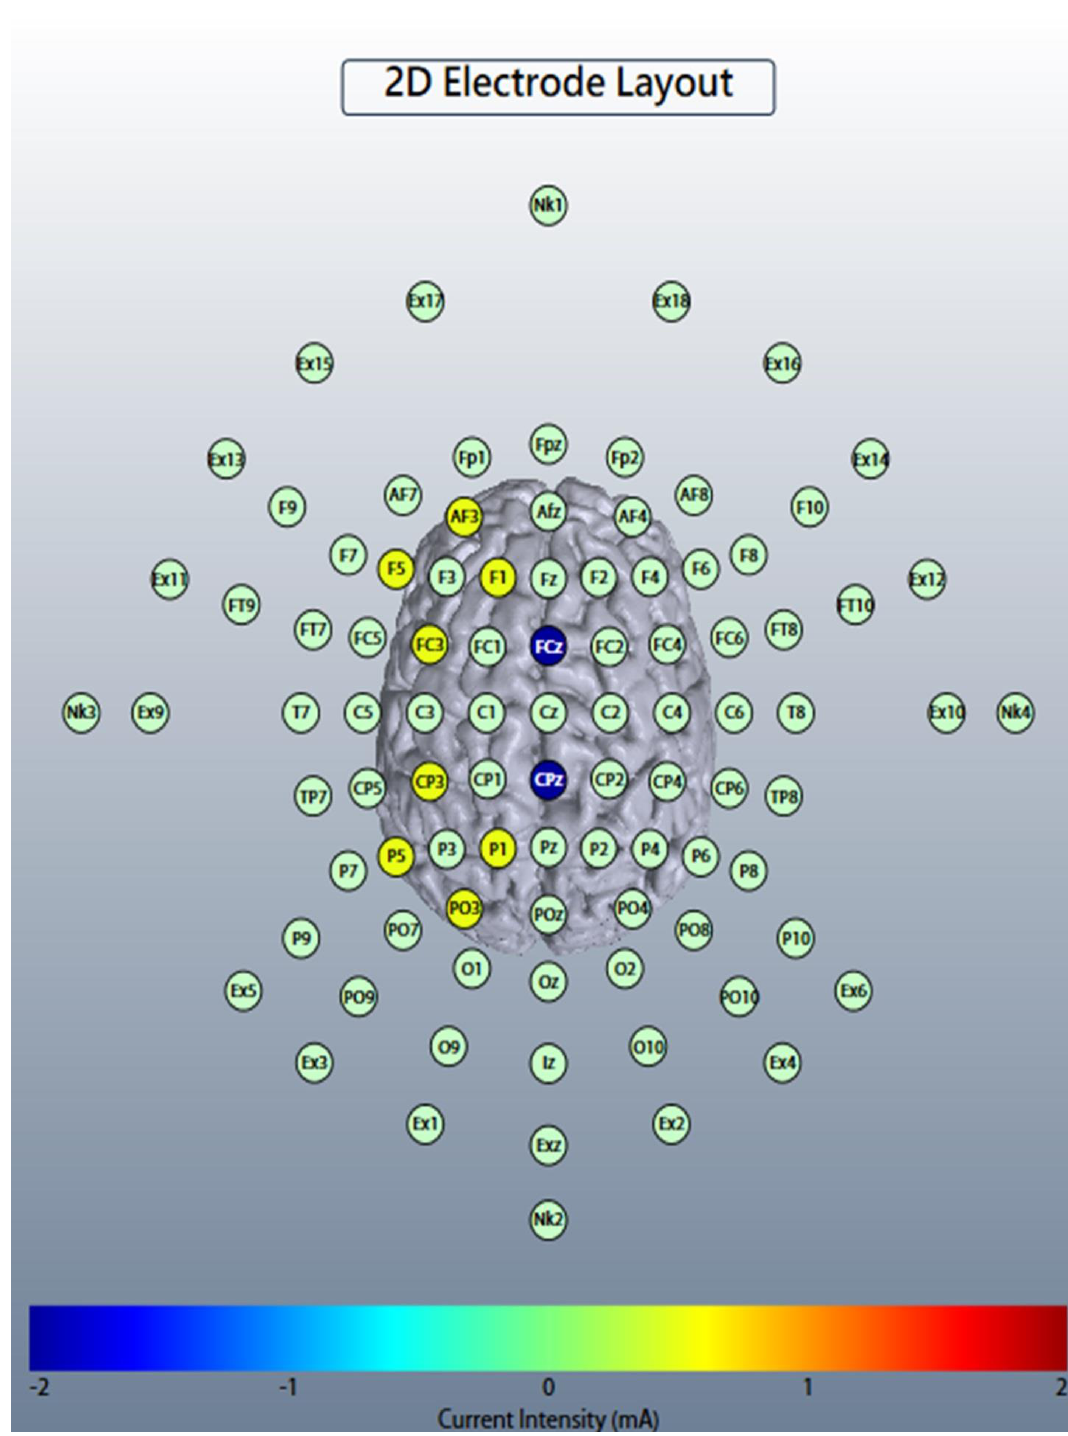
Figure 1. The 2D head model of left-hemispheric in-phase theta-rhythm frontoparietal high-definition transcranial alternating current stimulation (tACS). The electrodes of the first DC stimulator were placed at the International 10-10 electrode position F1, F5, AF3, and FC3 (stimulation electrodes) and CPz (return electrode). For the second stimulator, the electrodes were placed at P1, P5, CP3, and PO3 (stimulation electrodes) and FCz (return electrode). A custom-made pulse generator controlled the two stimulators and created an in-phase (synchronous) setup (0° relative phase difference between the output signals of the two tACS-stimulators). The color bar indicates the estimated current intensity that the electrodes of the stimulators